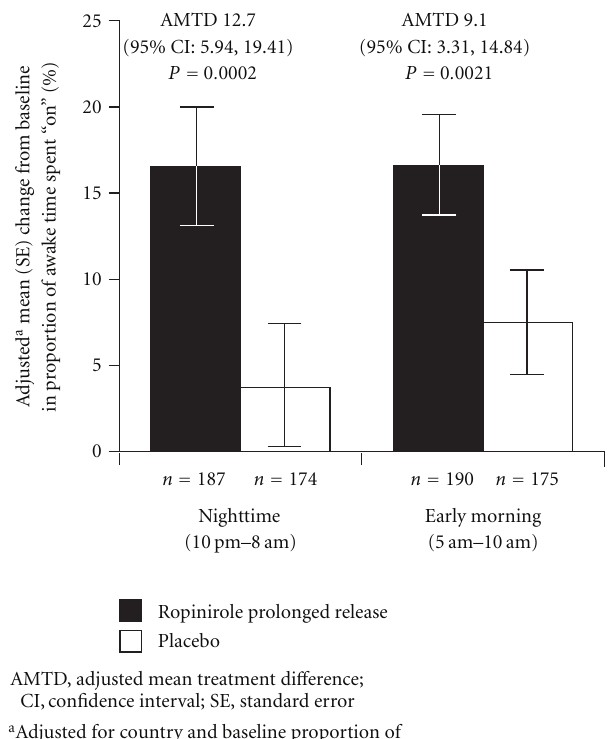
Figure 2: a Adjusted mean change from baseline at week 24 LOCF in the proportion of awake time spent “on” during the night and in the early morning (intent-to-treat